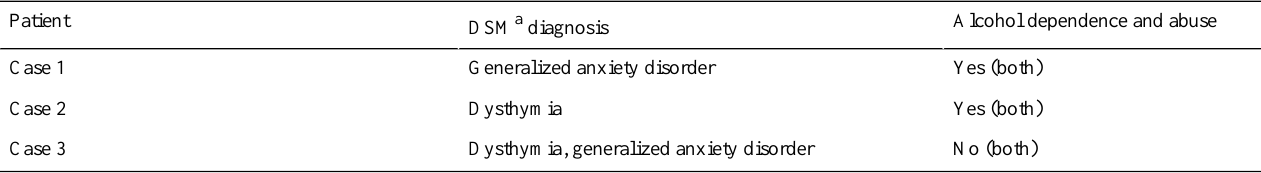
Table 2. Psychiatric diagnosis of selected patients.